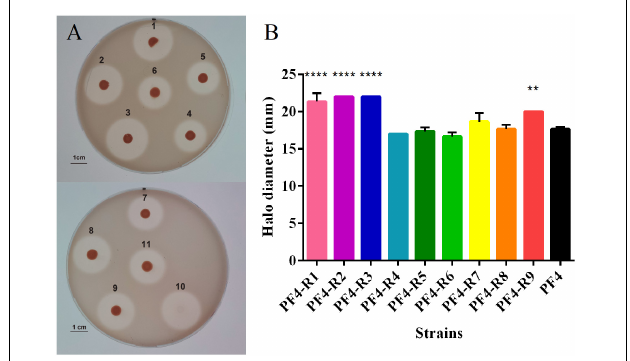
FIGURE 3 | Protease production of V. anguillarum strains resistant to the CHOED phage. (A) Protease production of different mutant strains resistant to CHOED. 1: PF4-R1; 2: PF4-R2; 3: PF4-R3; 4: PF4-R4; 5: PF4-R5; 6: parental PF4 strain; 7: PF4-R6; 8: PF4-R7; 9: PF4-R8; 10: PF4-R9 (colony removed by buffer addition); 11: parental PF4 strain. (B) Diameter of the proteolytic activity halo for the different resistant strains. Error bars represent standard deviation of triplicates. ( ∗∗ ) Significantly different from the parental PF4 strain ( p < 0.01); ( ∗∗∗∗ ) Significantly different from the parental strain ( p < 0.0001).